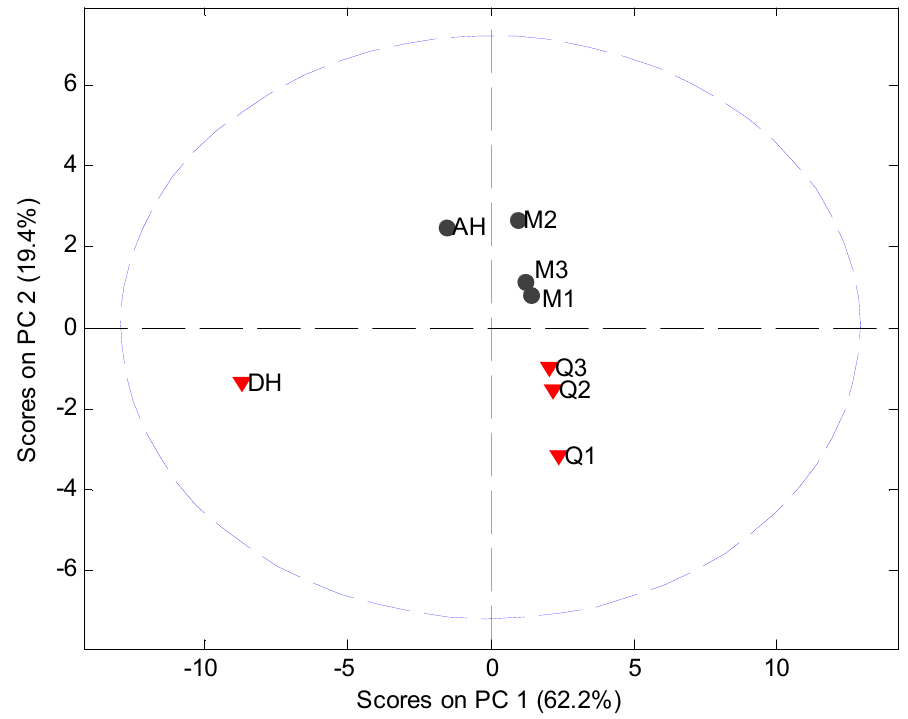
Figure 10. PCA score plot of PDF data (4 Å to 40 Å) using the 5° to 30° 2 θ XRPD diffraction range. Milled samples (M1, M2 and M3), quench cooled samples (Q1, Q2 and Q3), crystalline anhydrate (AH) and crystalline dihydrate